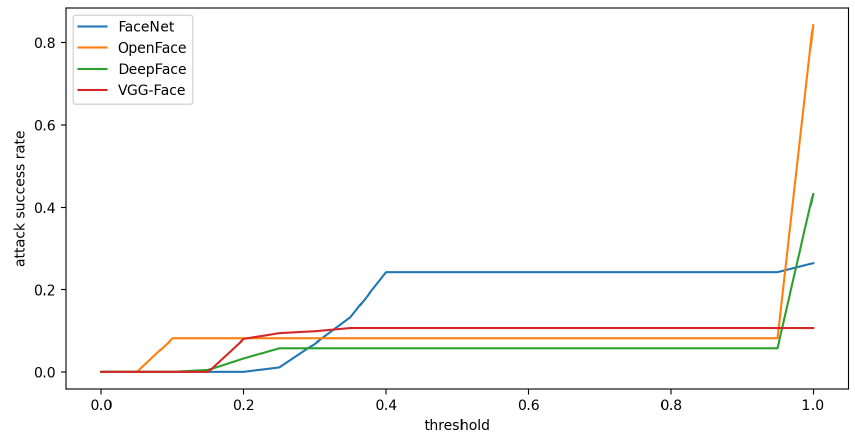
Figure 11. Compare the relationship between threshold and attack success